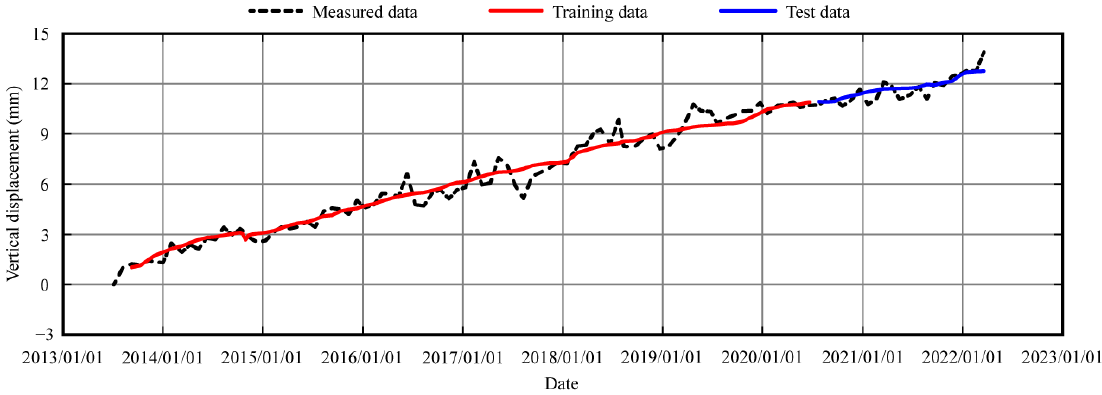
Figure 3. Process lines of settlement for measuring point LD12ZT01 (LSTM model).